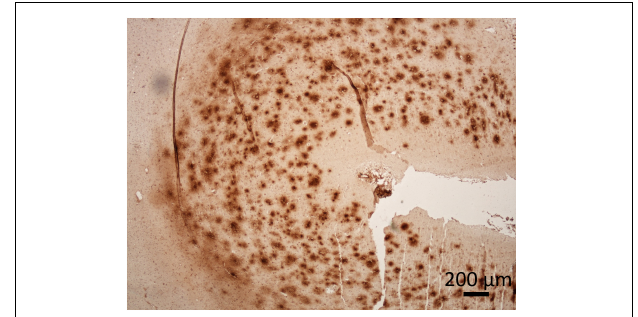
FIGURE 2 | Presence of A β in the cerebral cortex of a dog with CCD. The dense plaques detected in superficial cortical layers and diffuse plaques in deeper layers of prefrontal cortex. The dog was 17-years-old of a mixed breed. Immunoperoxidase staining with antibodies against A β (purified anti- β -Amyloid, 17-24 Antibody, BioLegend, #800701) with diaminobenzidine (DAB) as chromogen (brown), counter stained with hematoxylin. Original microphotograph made by the